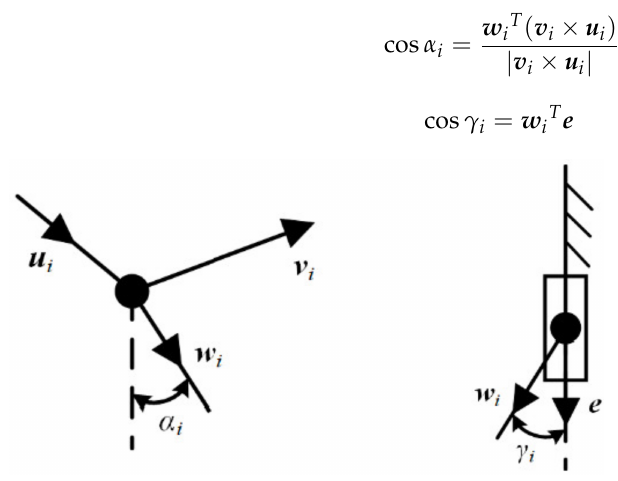
Figure 3. Angle relationship derived from matrices J qr and J qp